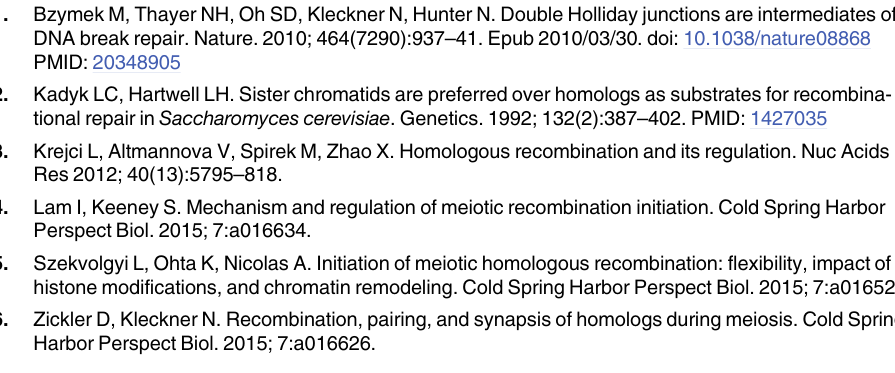
(TIF) S4 Fig. Schematics of the chromosomes from WT, dmc1 Δ hed1 Δ and dmc1 Δ hed1-3A tet- rads determined by Next Generation Sequencing. Blue indicates sequences derived from the SK1 parent, while red indicates sequence from S288c. Gaps indicate regions where that was no SNP genotype information. Black circles indicate centromeres. Chromosomes (indicated by Roman numerals) are arranged by chromosome number (I to XVI) from top to bottom. The scale at the bottom indicates the number of kilobases. (PDF) S5 Fig. Schematics of minority events from WT tetrads. E5: events between two chromatids; E6: events between three chromatids; E7, events between four chromatids. Blacks indicate the region of repair. (PDF) S6 Fig. Schematics of minority events from dmc1 Δ hed1 Δ tetrads. (PDF) S7 Fig. Schematics of minority events from dmc1 Δ hed1-3A tetrads.